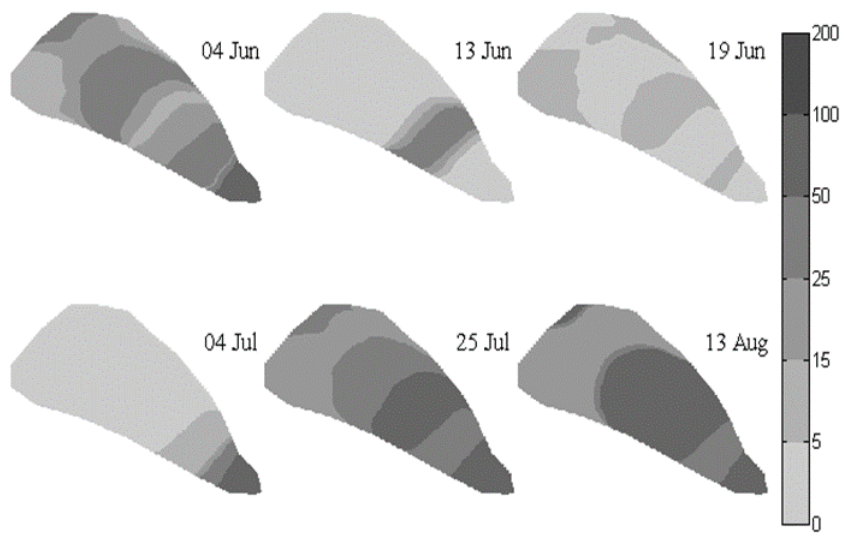
Figure 4. Spatiotemporal variations in dust concentrations (ppm) recorded in surface snow over the QT No. 1 Glacier from 4 June to 13 August in 2015. Not all data are shown due to a limited number of samples.